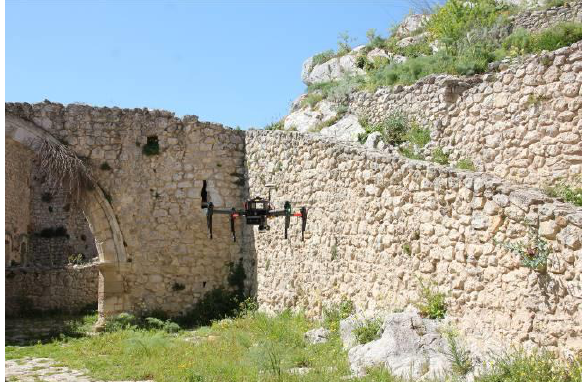
Figure 2. The survey operation of the castle with UAV